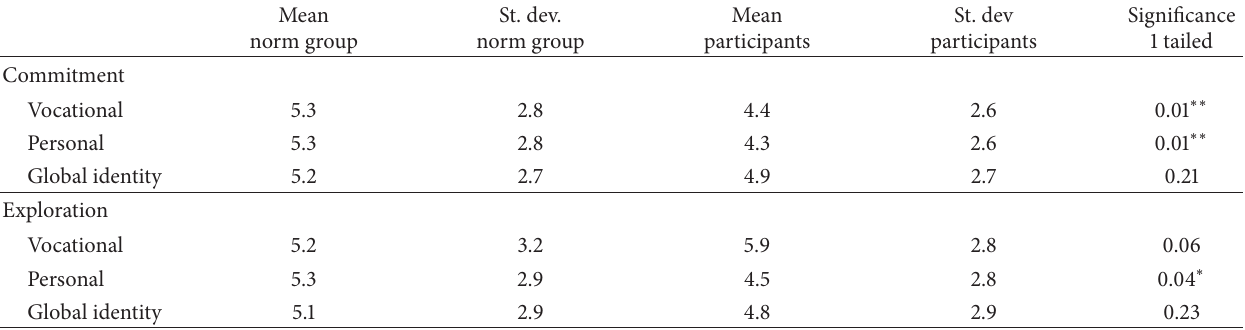
Table 2: Commitment and exploration per domain of the participants before the start of the guidance ( 𝑛 = 60 ) as compared to the norm group (decile